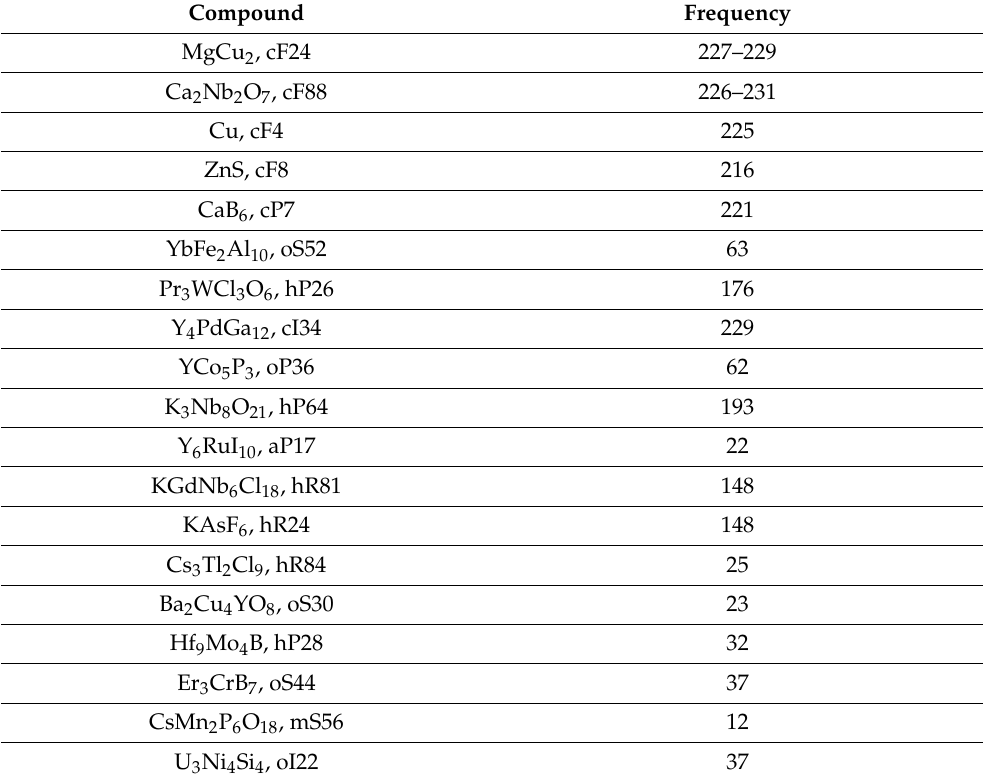
Table 4. Frequency of different inorganic compounds.